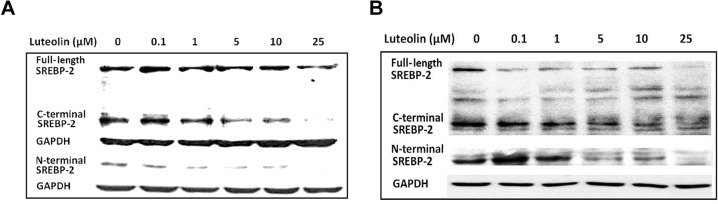
Immunoblot of SREBP-2 under luteolin treatment.Hepatic cells were cultured and treated with luteolin. After 24 h of treatment, the protein extracts were immunoblotted for SREBP-2. Images for SREBP-2 in WRL-68 cells and HepG2 cells are displayed in the left and right panels, respectively. The images represent one of two independent experiments with comparable results.